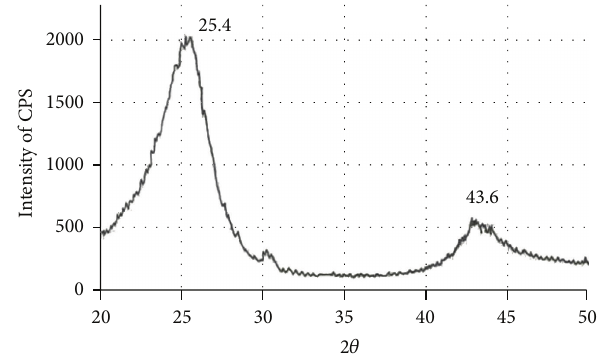
Figure 2: XRD pattern of the CNS powder.